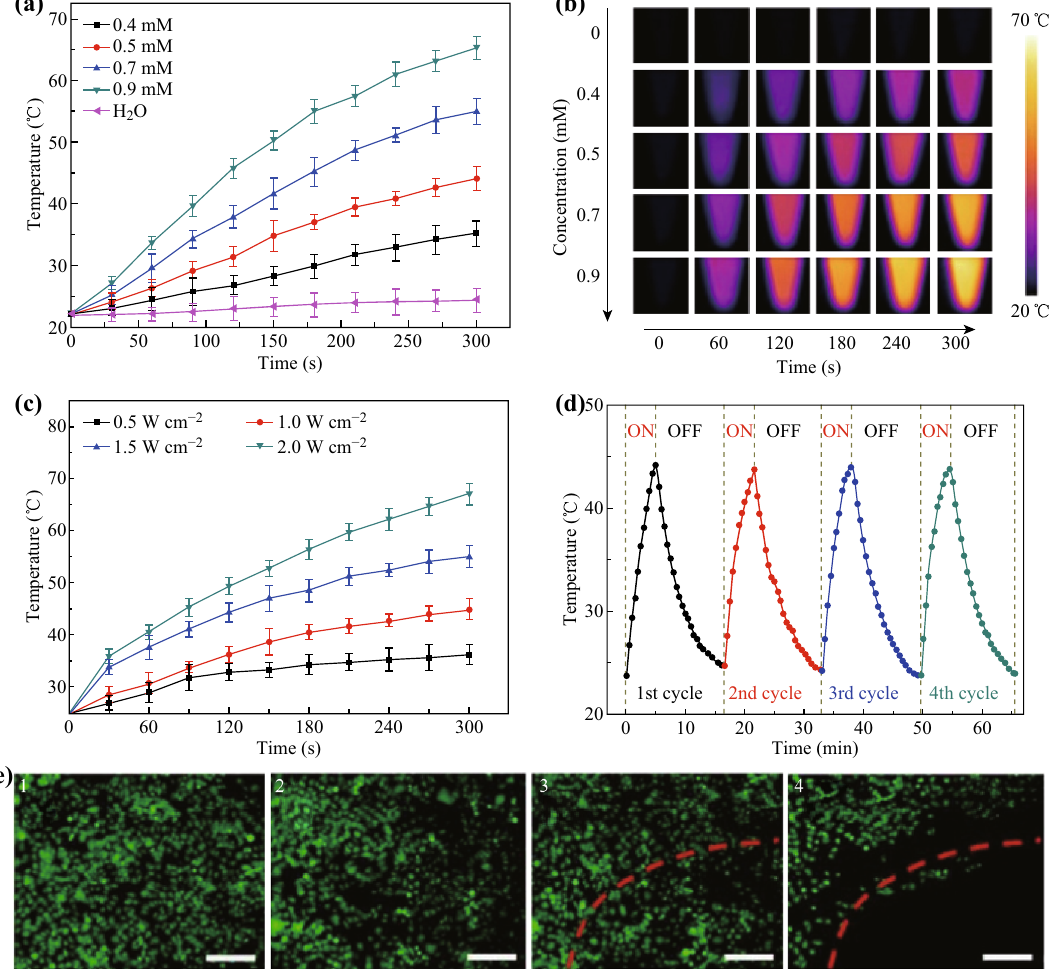
Fig. 2 a Variation of temperature as a function of different Au concentrations irradiated with an 808-nm laser (power density: 1.0 W cm - 2 ), b Photothermal images of the yolk–shell NPs solution at different Au concentrations, and pure water exposed to the 808-nm laser (1.0 W cm - 2 ) recorded at different time intervals, c NIR-induced temperature increase at various lasers power densities in aqueous solution (808 nm, 0.5 mM), d Temperature monitoring of the yolk–shell NPs aqueous suspension (the Au concentration: 0.5 mM) during for successive cycles of an on-and- off laser, e Fluorescence microscopy images of HeLa cells with different treatments via staining with calcein AM: (1) control; (2) yolk–shell NPs only; (3) laser irradiation only; (4) yolk–shell NPs with laser irradiation (scale bars: 200 l